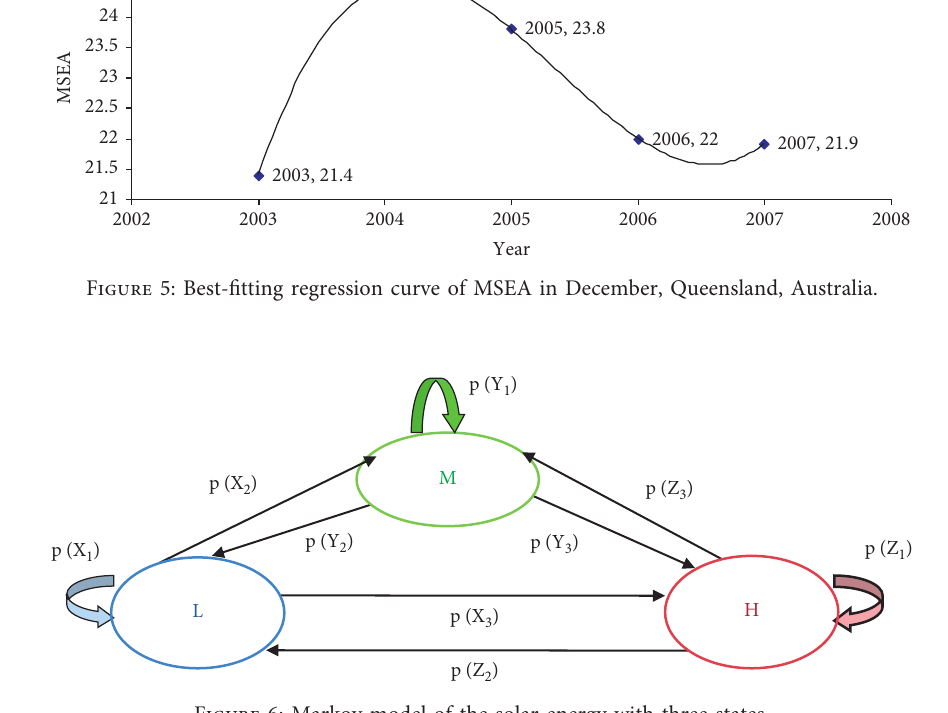
Figure 6: Markov model of the solar energy with three